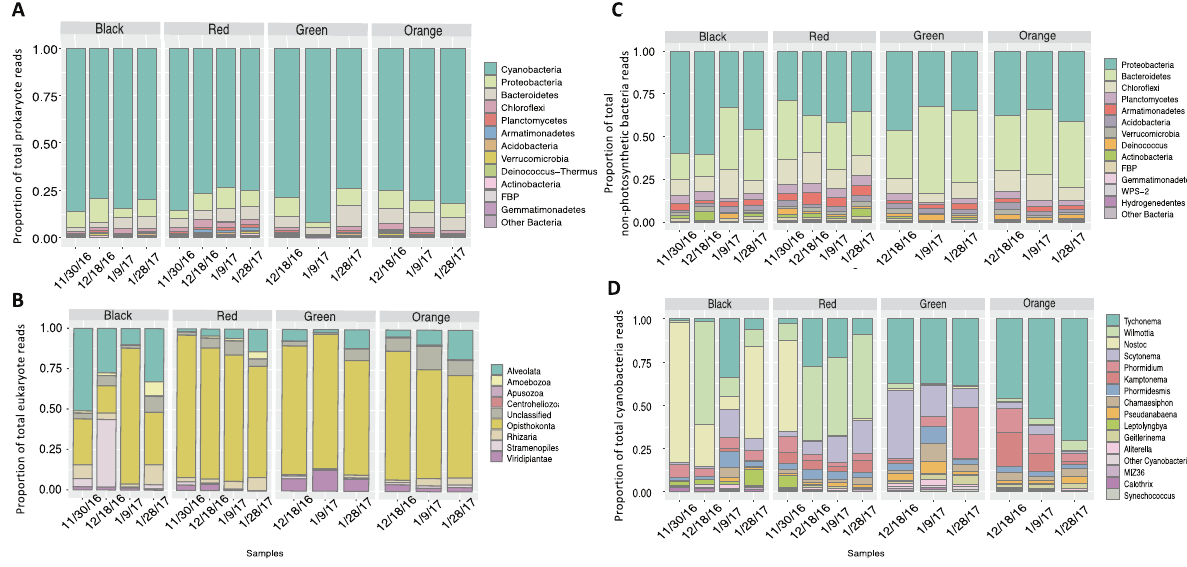
Fig. 2 Microbial mat community structuring. Relative abundance of ( A ) prokaryotic, ( B ) eukaryotic, ( C ) non-cyanobacterial, ( D ) cyanobacterial community members from non-plastid 16S and 18S rRNA